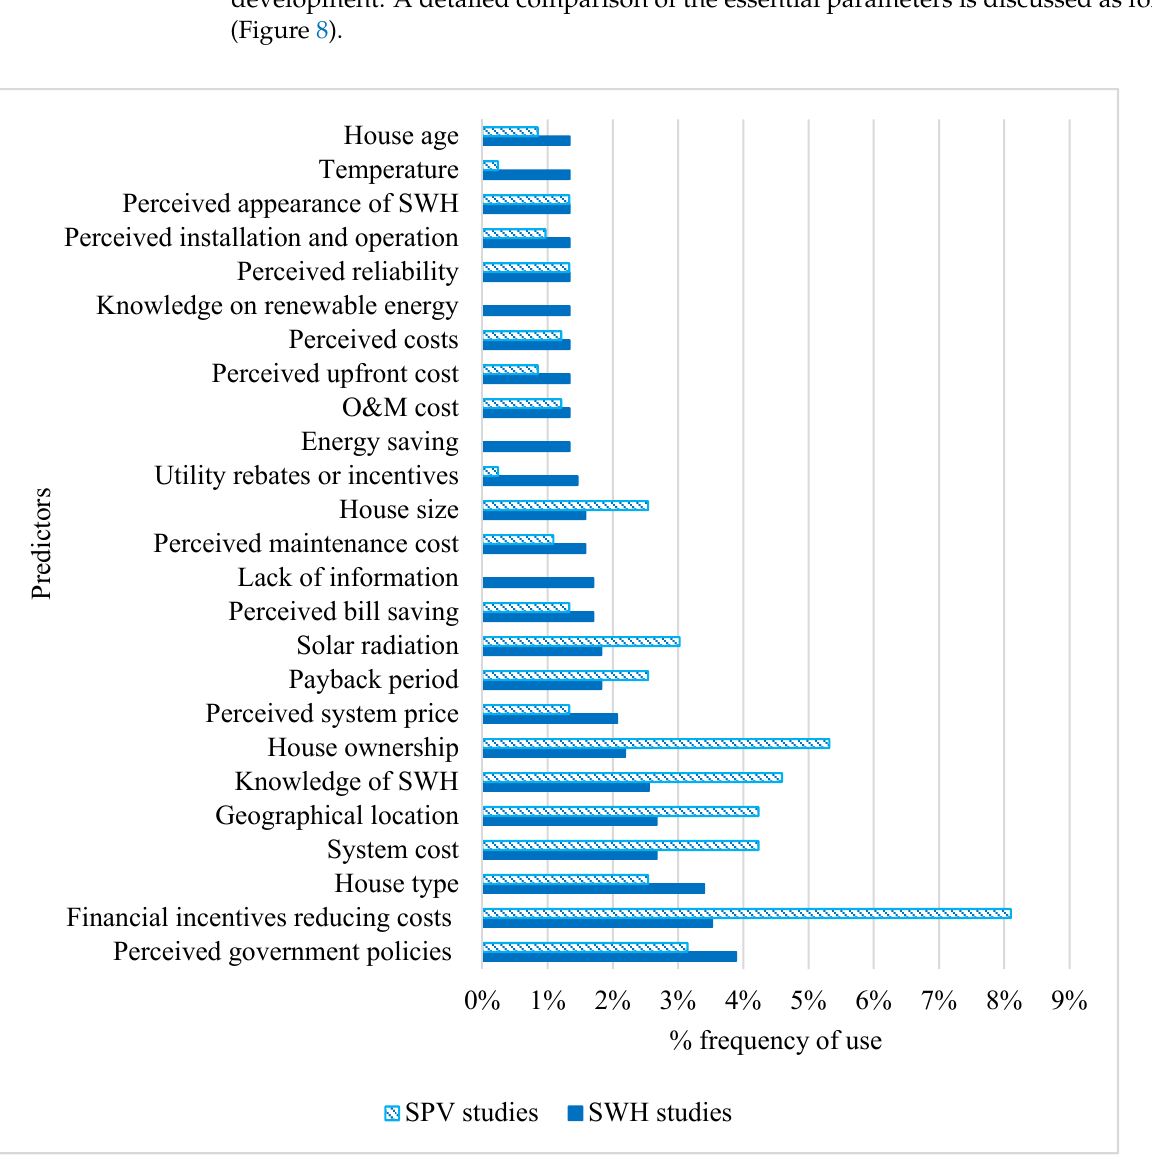
Figure 8. Comparison of the frequency of use among the SWH and SPV studies (data for SPV was adopted from [11]). The percentages were obtained as follows: (frequency of use for predictor * 100)/(total number of frequency of use in all categories in associated studies).